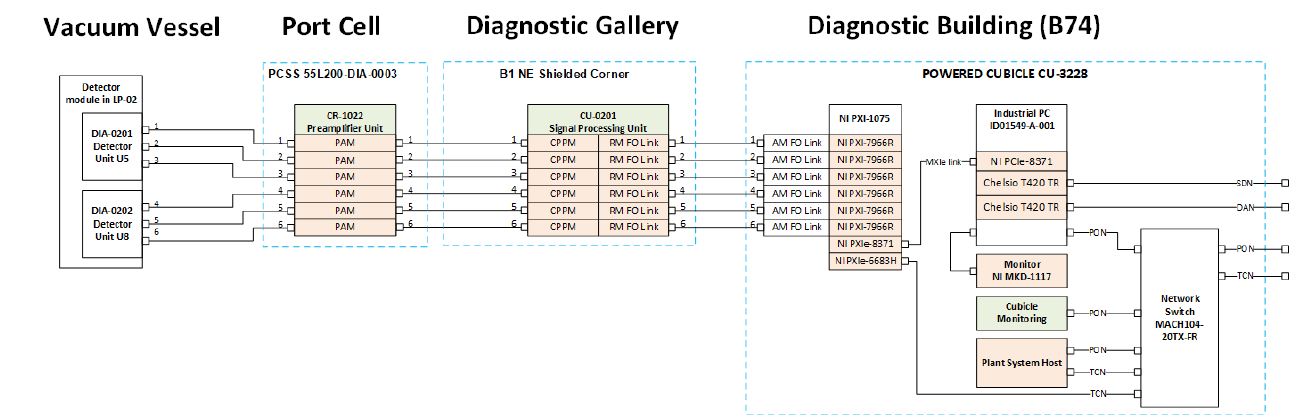
Fig. 1. The structure of the DNFM subsystem for single detector